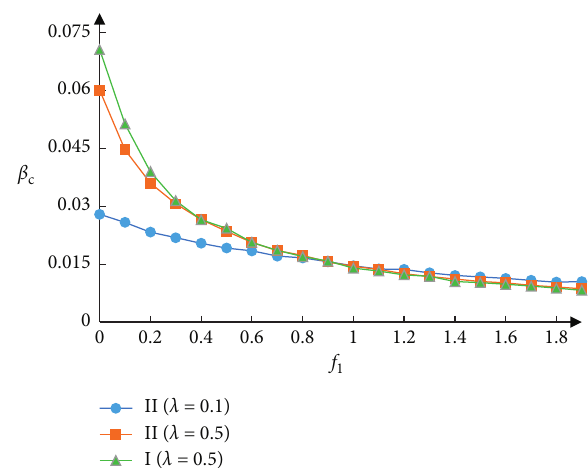
Figure 5: The influence of f